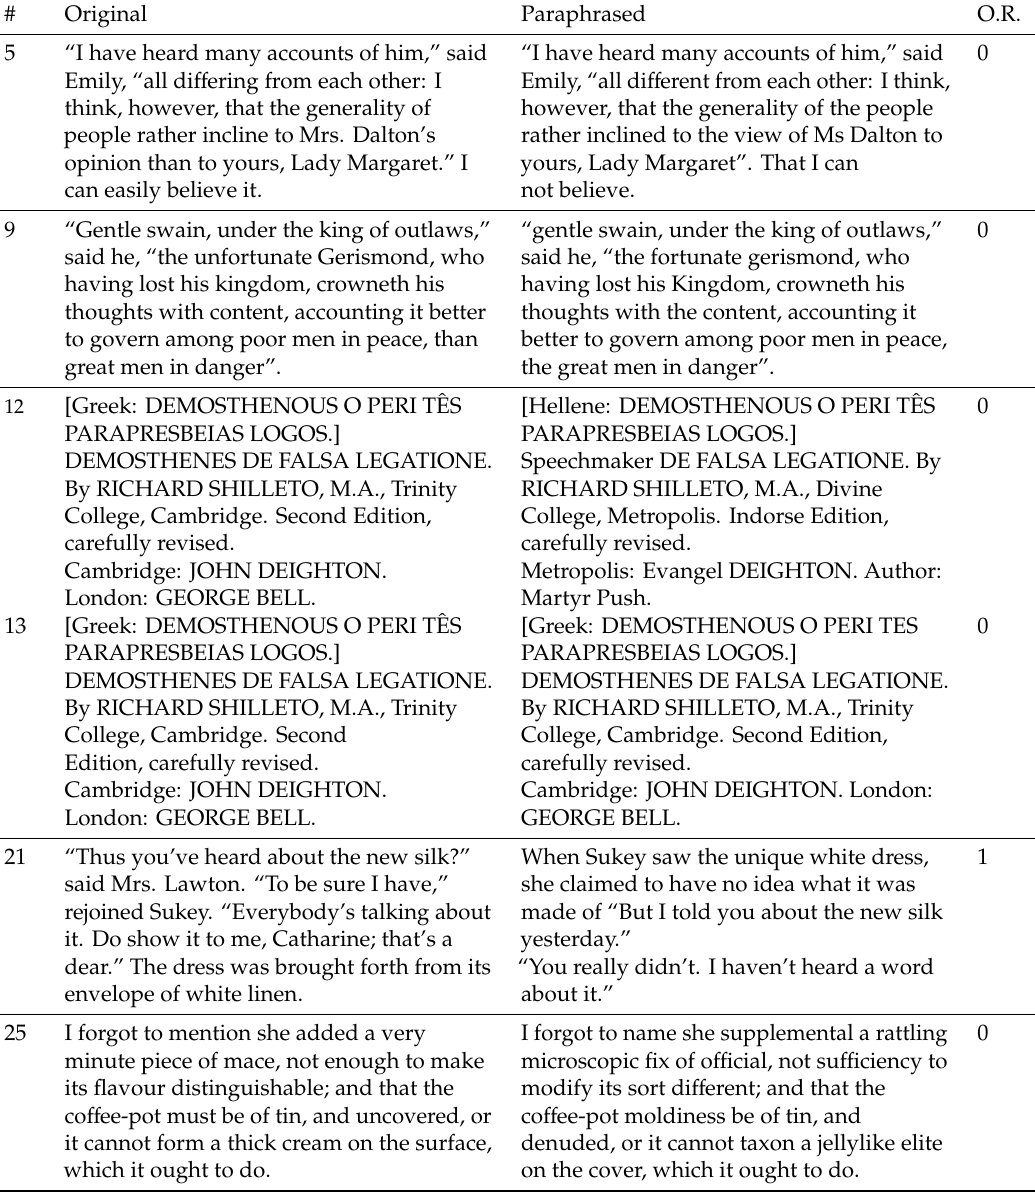
Table A1. Some O ffi cial Annotations for the Initial 25 Pairs of Webis